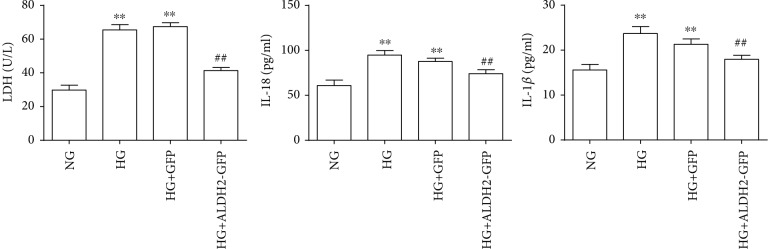
Levels of LDH, IL-18, and IL-1β after high glucose intervention (mean ± SD, n = 5). ∗∗P < 0.01vs. NG; ##P < 0.01vs. HG and HG+GFP.